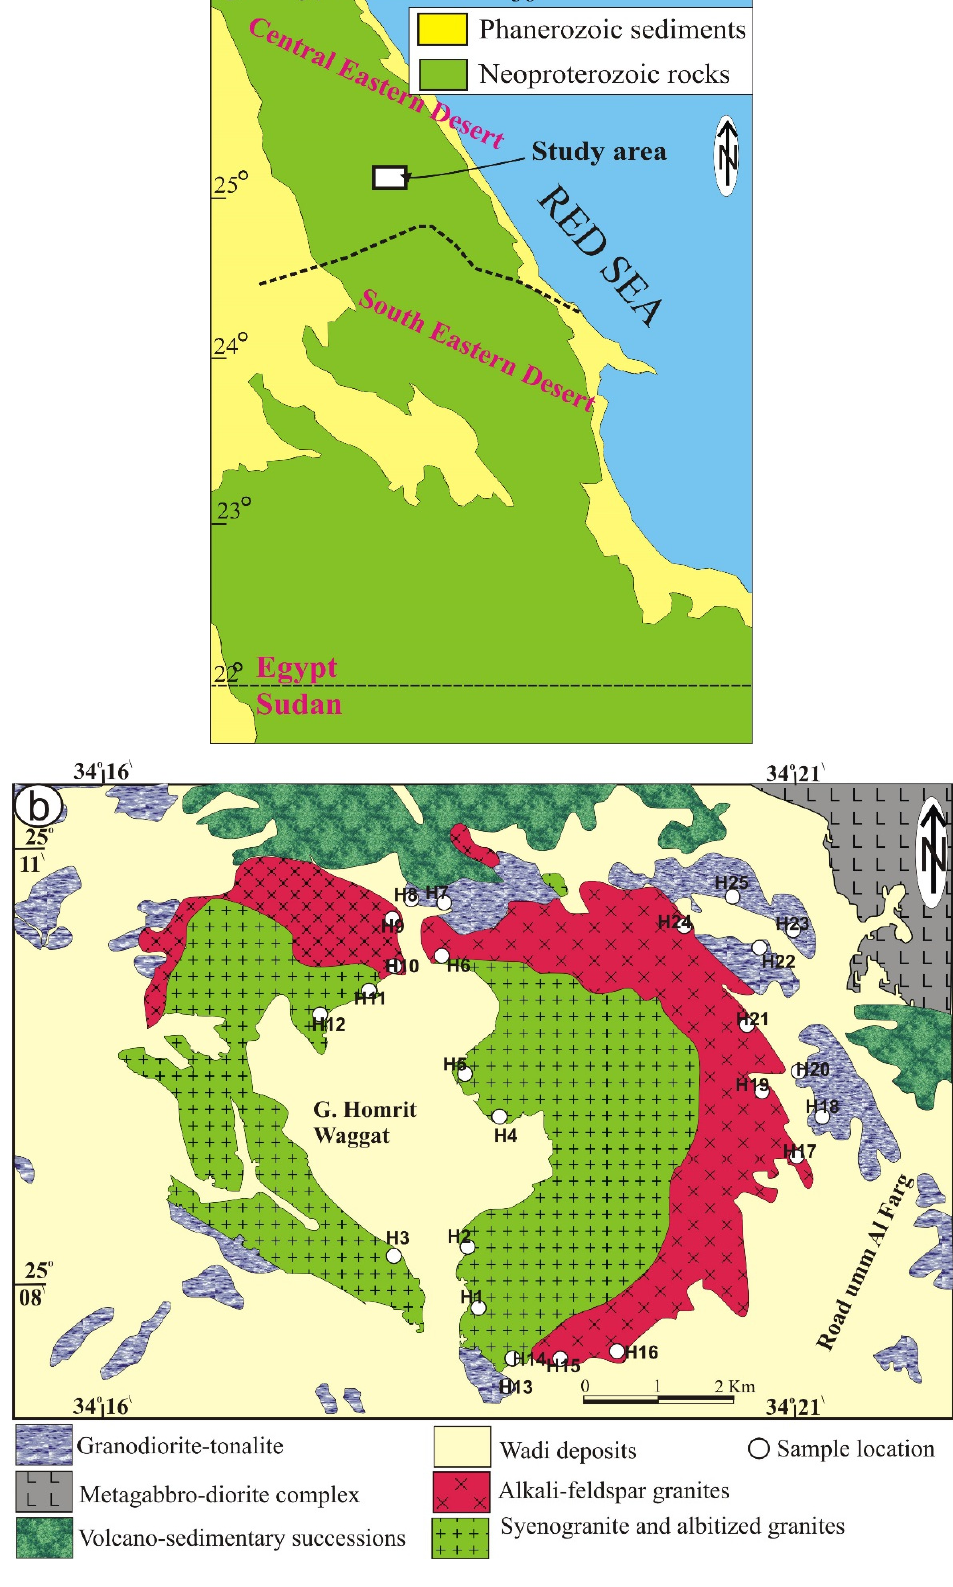
Figure 1. ( a ) Location map of Homrit Waggat area, Central Eastern Desert of Egypt; ( b ) geologic map of Homrit Waggat area modified after [10].